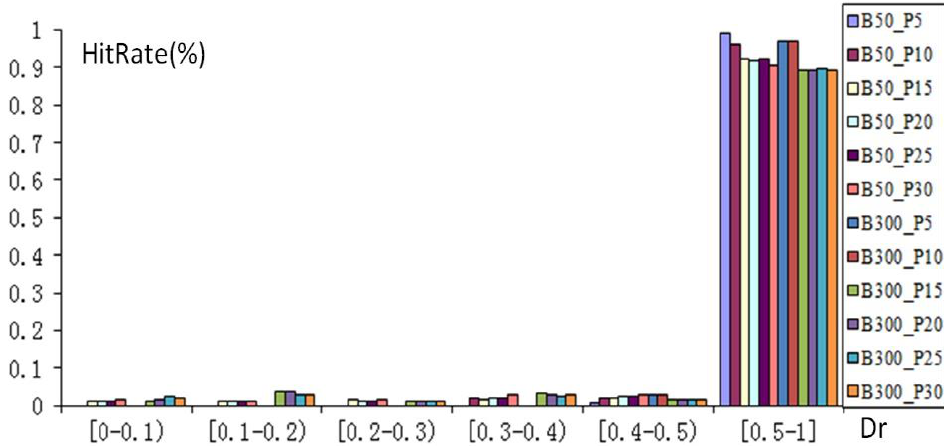
Figure 29. HitRate and Dr under different conditions.